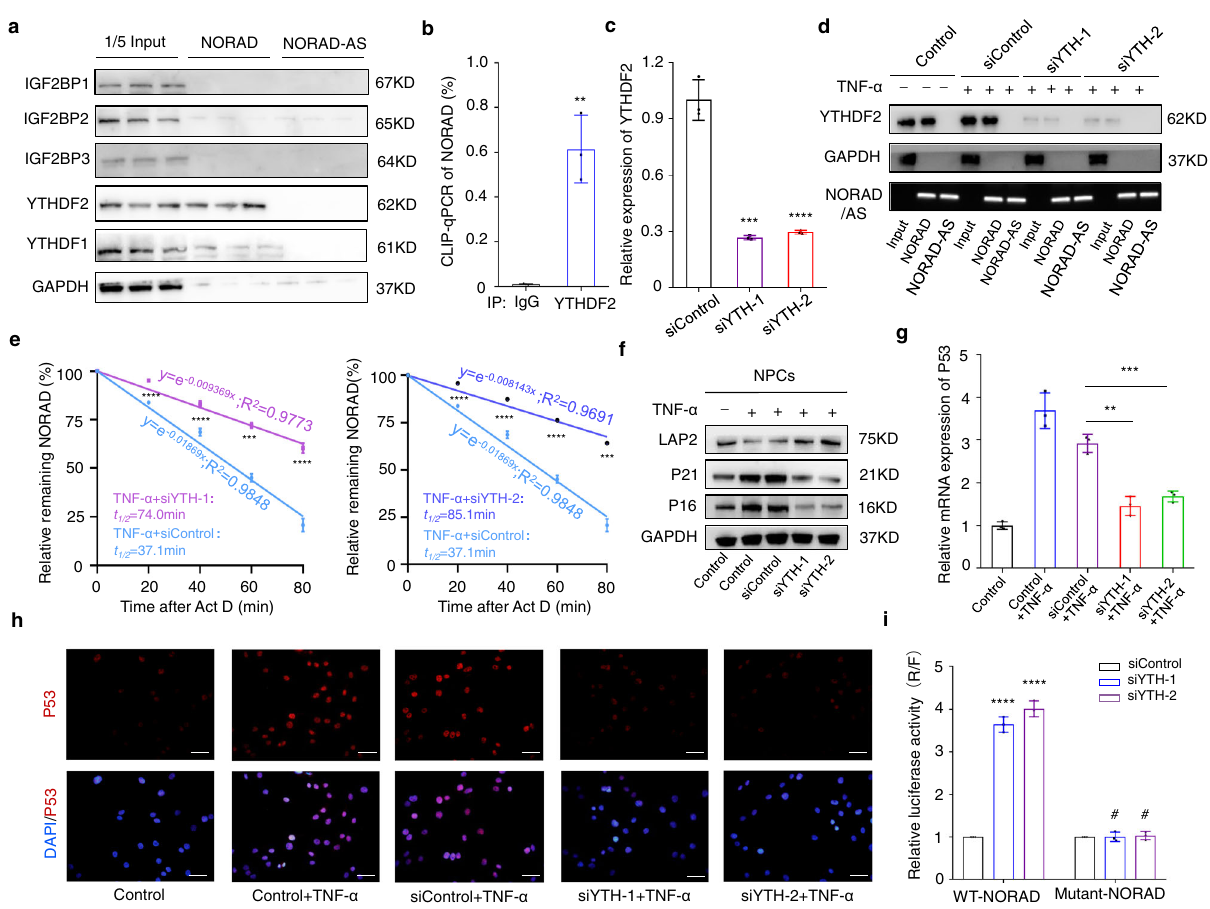
Fig. 6 Reduced stability of NORAD is mediated by YTHDF2. a RNA-pulldown assay showed that YTHDF2 interacted with NORAD, three independent experiments were repeated. b CLIP-qPCR of YTHDF2 showed that NORAD interacted with YTHDF2. Data are shown as the mean ± SD, n = 3, P = 0.0023, two-tailed unpaired Student ’ s t test. c mRNA expression of NORAD in NPCs with or without YTHDF2 silencing (siYTH-1: siRNA against YTHDF2#1, P = 0.0003; siYTH-2: siRNA against YTHDF2#2, P = 0.0004). Data are shown as the mean ± SD, n = 3, *** P < 0.001, two-tailed unpaired Student ’ s t test. d RNA Pulldown assay showed the interaction of YTHDF2 with NORAD in normal or senescent NPCs with or without YTHDF2 silencing using probes of NORAD or NORAD-AS probes. e Stability assay of NORAD in senescent NPCs with or without YTHDF2 silencing at 20 ( P < 0.0001; P < 0.0001), 40 ( P = 0.0004; P < 0.0001), 60 ( P < 0.0001; P < 0.0001), 80 min ( P < 0.0001; P = 0.0001). Data are shown as the mean ± SD from three independent experiments. *** P < 0.001, **** P < 0.0001, two-tailed unpaired Student ’ s t test. f Protein level analysis of LAP2, P21 and P16 in normal and senescent NPCs with or without YTHDF2 silencing by western blot, GAPDH was used as the loading control. g Relative mRNA expression of P53 in normal and senescent NPCs with or without YTHDF2 silencing by RT-qPCR. Data are shown as the mean ± SD, n = 3, ** P < 0.01, *** P < 0.001, two-tailed unpaired Student ’ s t test, comparisons between siYTH-1 + TNF- α ( P = 0.0012) or siYTH-2 + TNF- α ( P = 0.0010) and TNF- α groups. h IF analysis of P53 in normal and senescent NPCs with or without YTHDF2 silencing (red: P53; blue: DAPI; scale bar: 50 μ m). i Dual-luciferase reporter assay of wild-type ( P < 0.0001; P < 0.0001) or site-mutant ( P = 0.9212; 0.5489) NPCs with or without YTHDF2 silencing. Data are shown as the mean ± SD, n = 3. # NS, **** P < 0.0001, two-tailed unpaired Student ’ s t